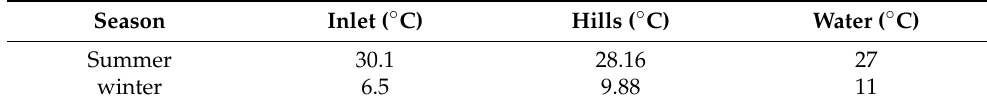
Table 3. Temperature of the main